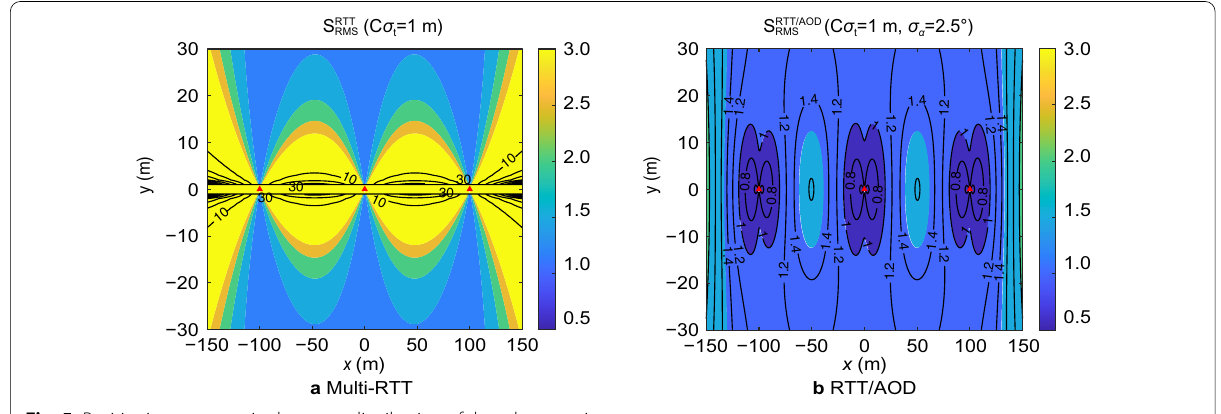
Fig. 5 Positioning accuracy in the worst distribution of three base